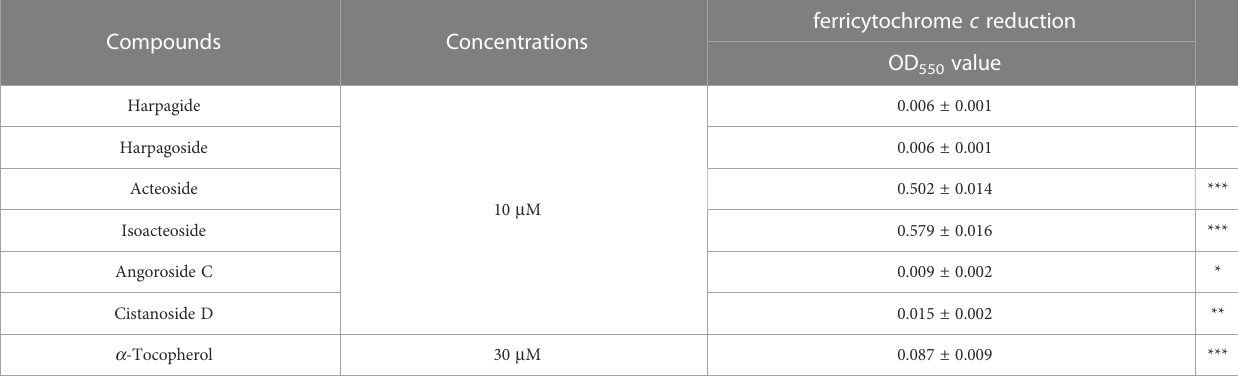
TABLE 2 The effect of S. ningpoensis compounds in the ferric reducing antioxidant power (FRAP)